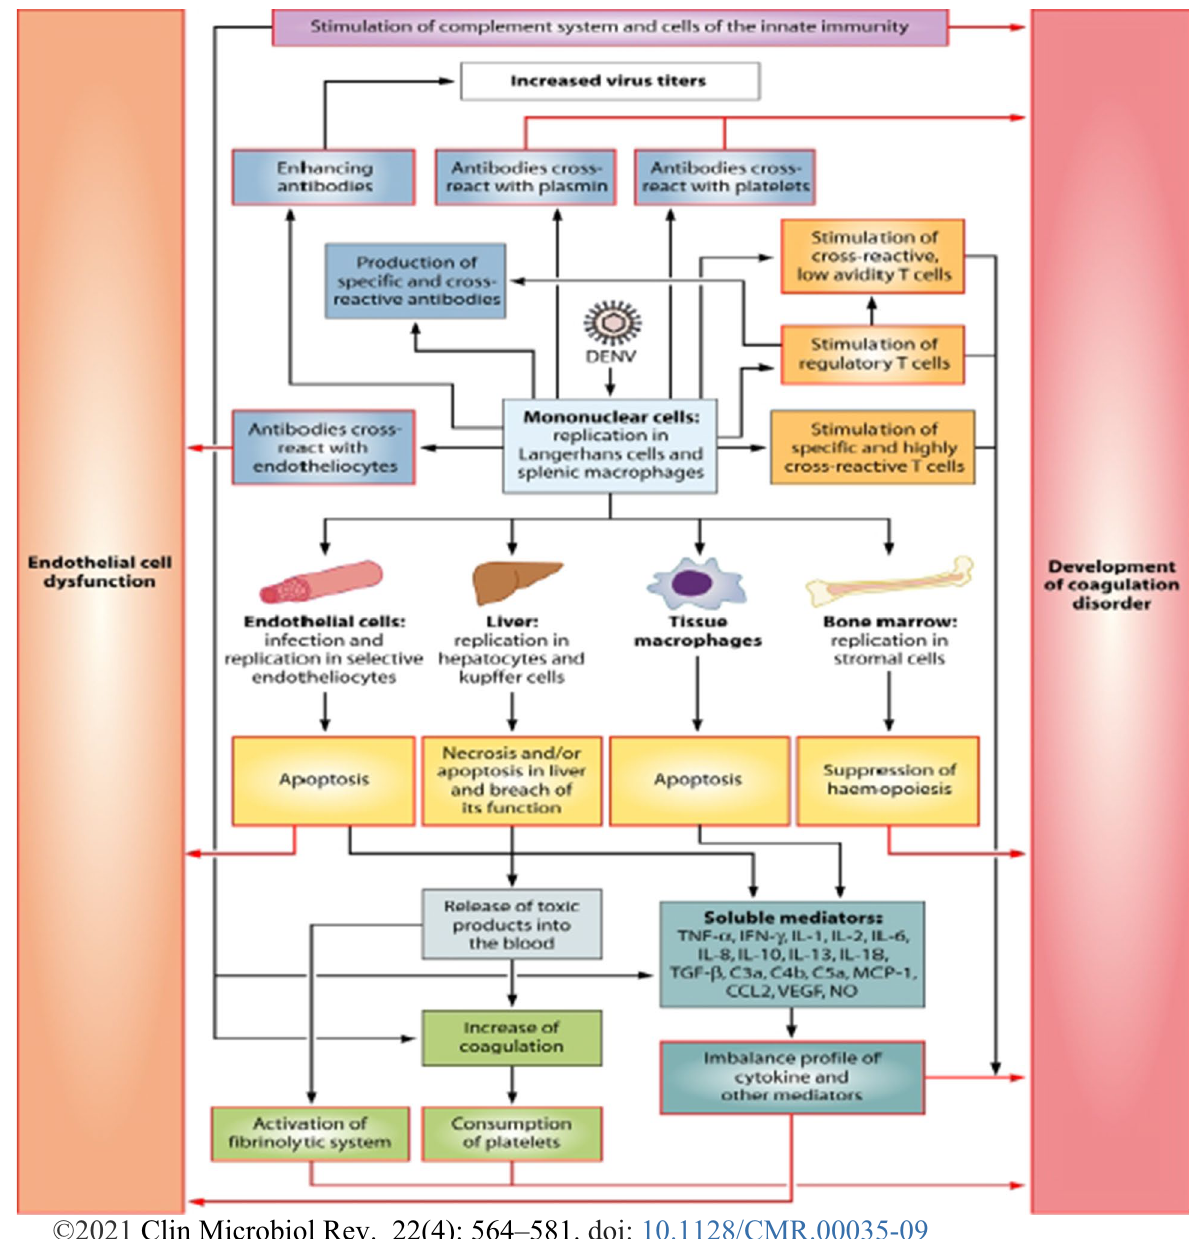
Fig. 4 Model for the pathogenesis of DF, DHF, and DSS. Black arrows—processes leading to the indicated event; colored boxes with white centers– pathological events. Each event will ultimately affect the EC or the hemostatic system (purple